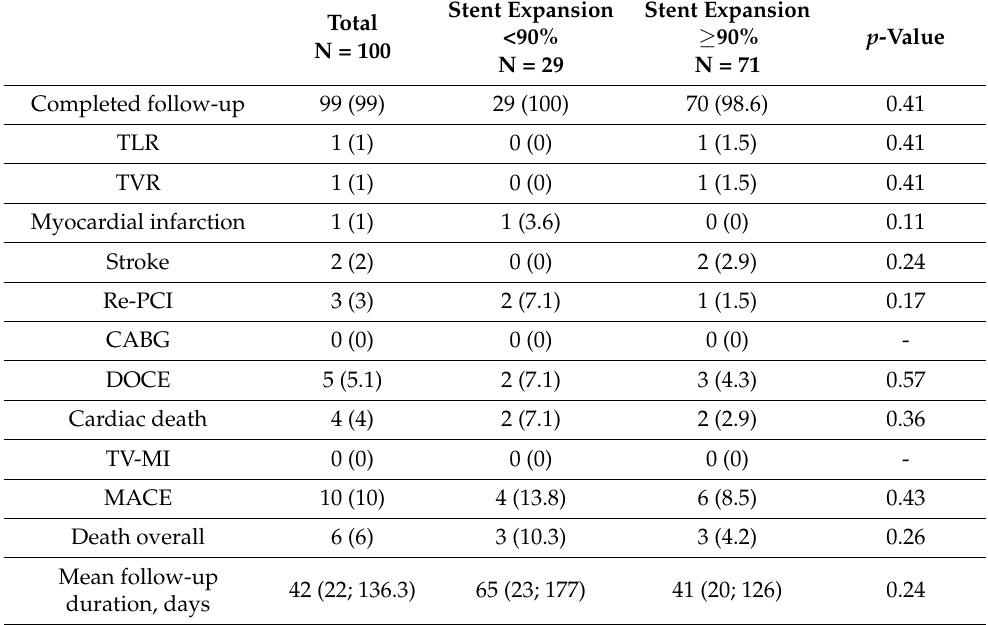
Table 6. Clinical outcomes.